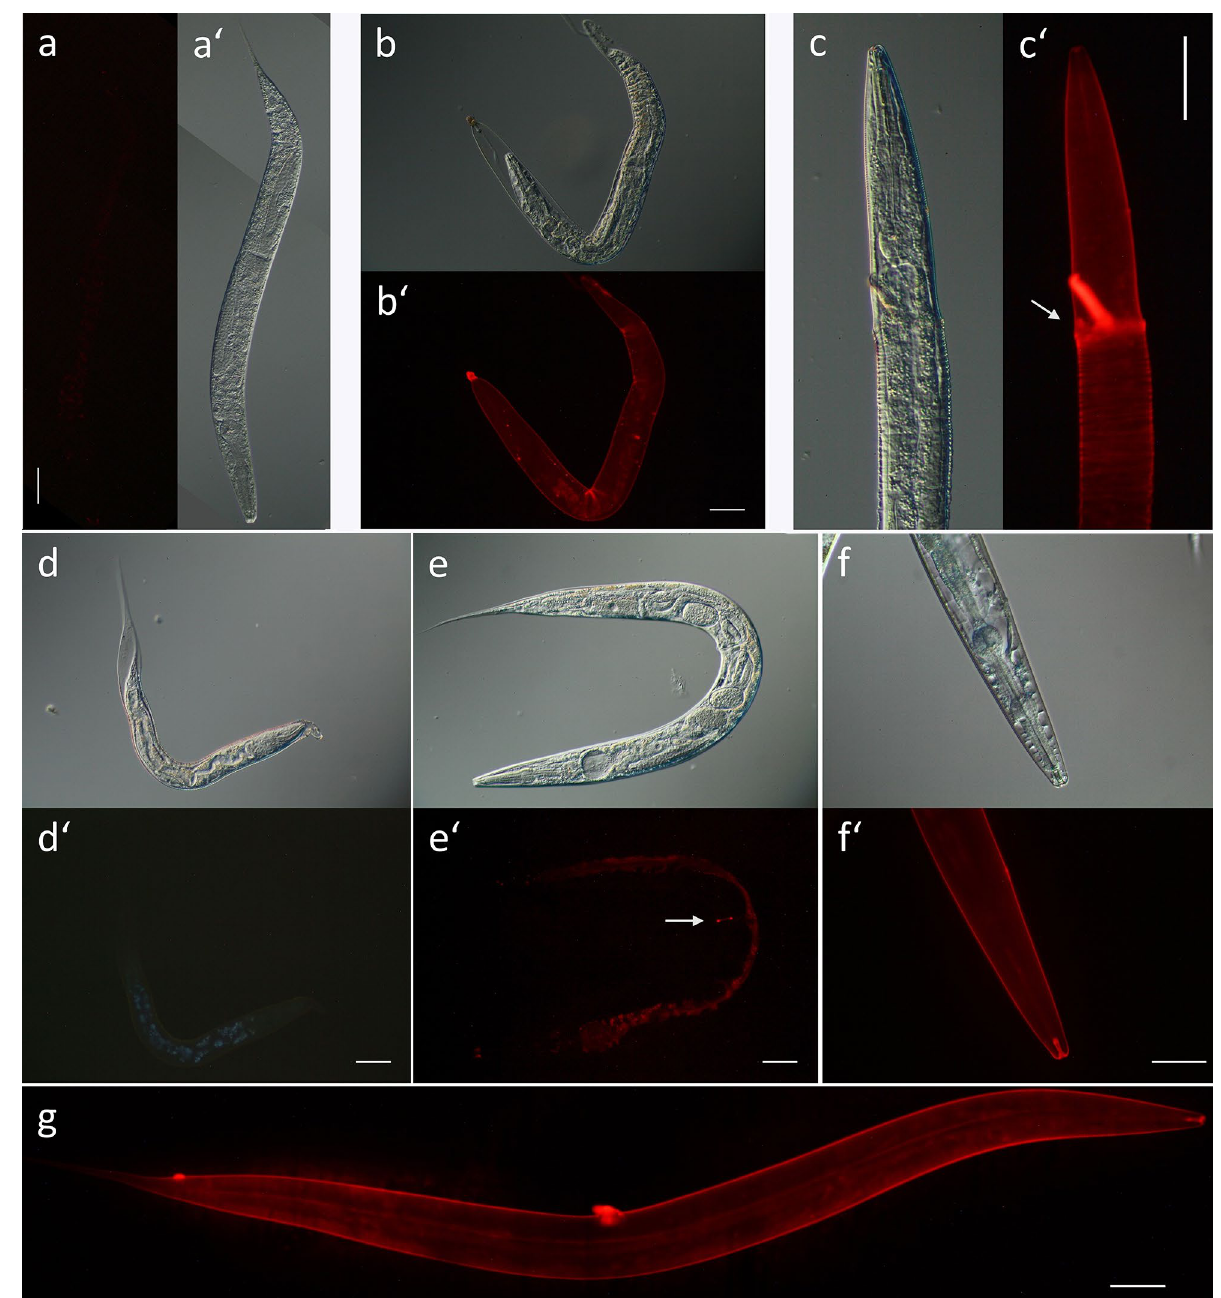
Figure 7. DIC and fluorescence microscopy of C. elegans L4 ( a – d ) and adult worms ( e – g ) after 24 h of treatment. ( a , a’ ): Untreated control (M9 buffer with 1% DMSO) stained with Wheat Germ Agglutinin, Alexa Fluor 594 Conjugate (WGA). ( b – d’ ) L4 larvae treated with CM (2 mg/mL) and subsequently stained with WGA ( b’ , c’ ) or fluorescence (λ ex 350/λ em 430 nm) detected without staining ( d’ ). Arrow indicates the partially shed cuticle strongly stained with WGA ( c’ ). ( e , e’ ) Untreated adult stained with WGA. Arrow indicates vulva, fluorescence within the worm corresponds to autofluorescence. ( f , f’ ) Head region of CM-treated worm after WGA staining, showing strong fluorescence in the buccal capsule. ( g ) CM-treated adult worm stained with WGA. Scalebar 50 increase in cuticle stiffness could possibly account for differential gene expression in tissues unrelated to the cuticle after tannin treatment 50 . Regarding the reduced motility observed in tannin-treated adult C. elegans 26 , this effect can either be caused by a decreased flexibility of the cuticle 51,52 or by a direct effect on the worms’ muscles or extracellular matrix components transmitting force to the cuticle 53 . Our microscopic observations in treated worms did not reveal clear visible damages to tissues underlying the cuticle and no detachments of the hypodermis from the cuticle as